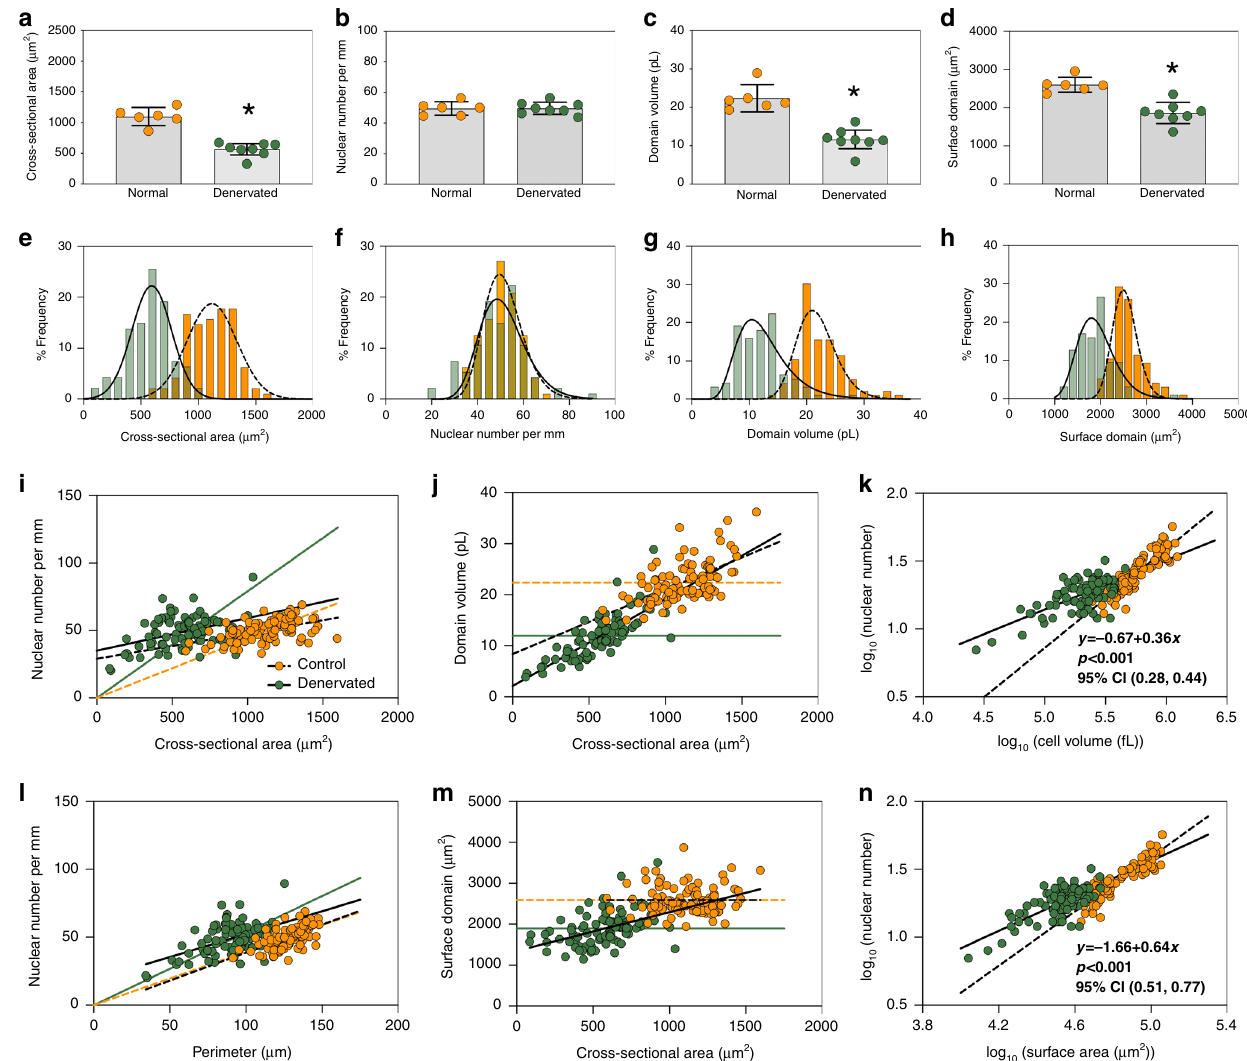
Fig. 3 Relationship between nuclear number and cell size after 14 days of denervation. a – d Highlights the mean (arithmetic) value per muscle, while e – h shows the frequency distribution per fi ber, for cross-sectional area ( a , e ), nuclear number per mm ( b , f ), domain volumes ( c , g ), and surface domains ( d , h ) in denervated muscle (green) and normal muscle (orange, these are the same data as presented in Fig. 1). Asterisks (*) indicate signi fi cantly different means based on results from two-sided Welch ’ s t -test: a ( p < 0.0001, t = 7.707, and df = 9), b ( p = 0.9719, t = 0.03611, and df = 10), c ( p = 0.0001, t = 6.220, and df = 9) and d ( p < 0.0001, t = 5.857, and df = 12). i – n Relationships of nuclear number and fi ber size analyzed for denervated muscle (green) compared to normal muscles (orange). Statistics for the normal muscles are presented in Fig. 1. i Nuclear number per mm versus cross-sectional area for denervated fi bers (solid black line) tested against a linear scaling ( b = 1, green solid line). Comparison of fi ts gave a F -value of 109.9 ( p < 0.0001). j Domain volumes versus cross-sectional area were tested against the solid green line ( b = 0). Comparison of fi ts gave an F -value of 153.1 ( p < 0.0001). k Nuclear number versus cell volume plotted and analyzed in log – log space gave a slope of b = 0.36 (95% CI: 0.28, 0.44). l Nuclear number per mm versus the fi ber perimeter were statistically tested against a linear relationship (solid green line). Comparison of fi ts yielded a F -value of 11.51 ( p = 0.0010). m Surface domains versus cross-sectional area tested against a horizontal slope ( b = 0, solid green line), gave an F -value of 23.85 ( p < 0.0001). n Nuclear number versus surface area plotted in log – log space gave a slope of b = 0.64 (95% CI: 0.51, 0.77). In i – n regression lines were fi tted w i th an OLS method with (1, 92) degrees of freedom and compared with the extra sum-of-squares F -test. n = 8 (denervated) and 6 (normal) muscles for a – d , while n = 94 (denervated) and 96 (normal) cells for e – h . Error bars in a – d represent the 95% CI and the curves in e – h were fi tted by a Gaussian function. Source data are provided as a Source Data fi